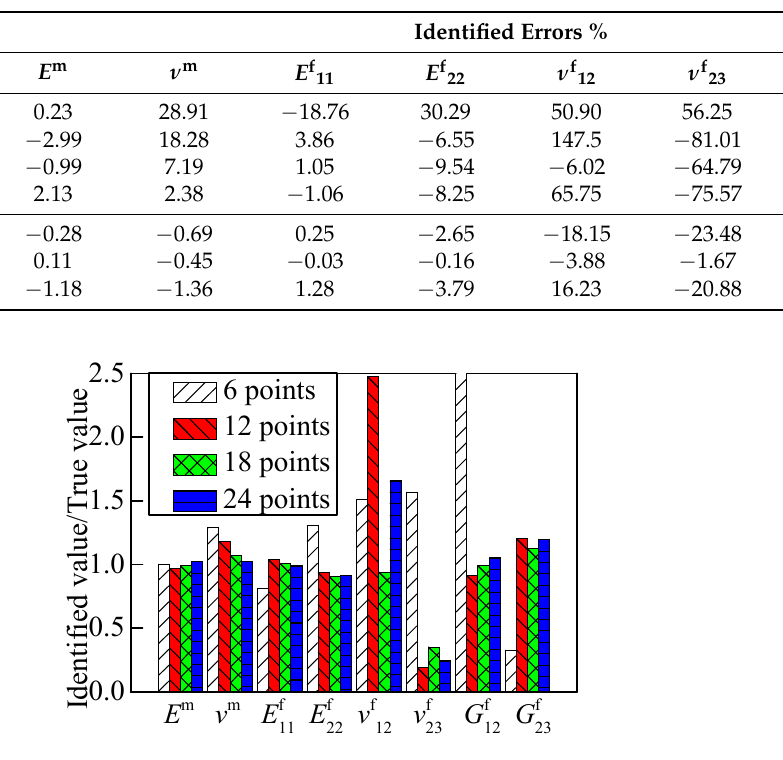
Figure 10. RVE identified result with different numbers of points (x and y directions).